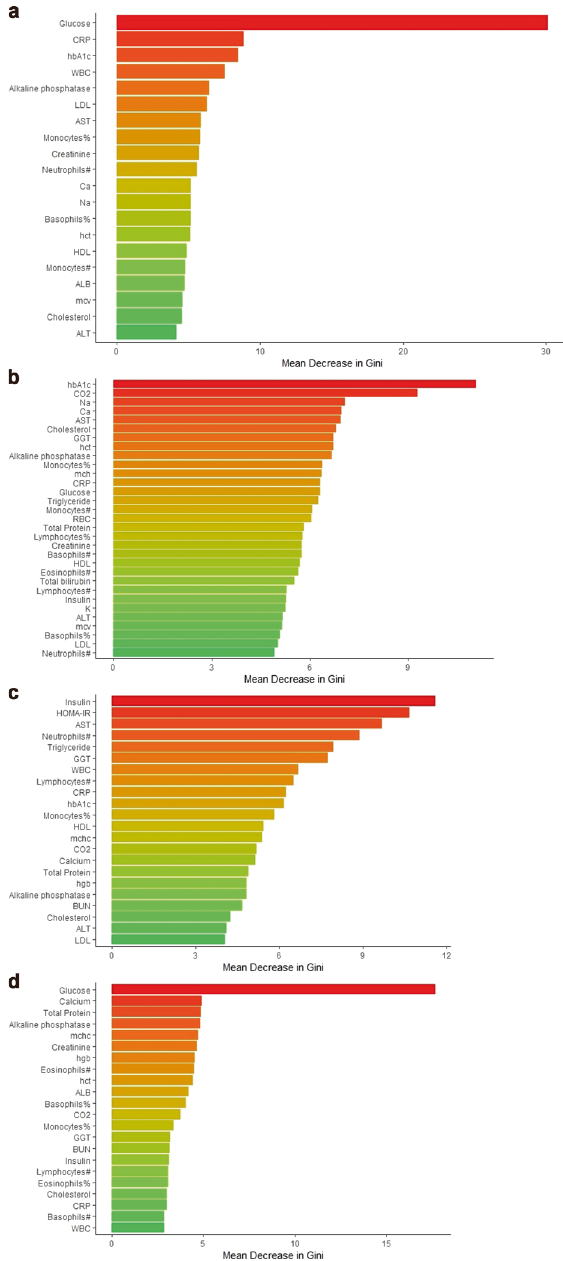
Fig. 1 Discriminating PTSD, TBI, and PTSD comorbid with TBI from Healthy Controls- Feature Importance. a Discriminating PTSD from Healthy Controls- Feature Importance b Discriminating TBI from Healthy Controls- Feature Importance c Discriminating PTSD comorbid with TBI from Healthy Controls- Feature Importance d Discriminating PTSD from TBI- Feature Importance.